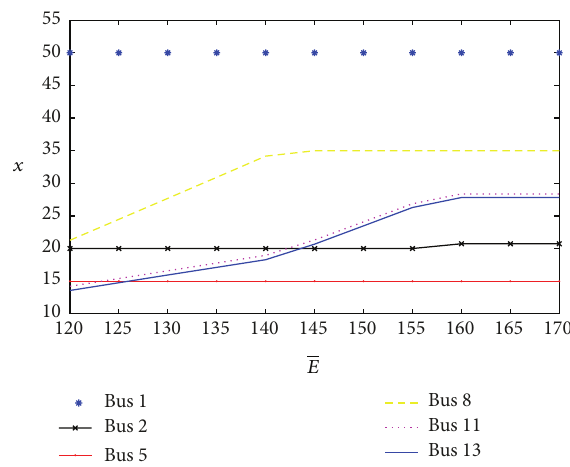
system. Numerical results show that parameter 𝛾 1 of mean is sensitive to the solution and parameter 𝛾 2 of